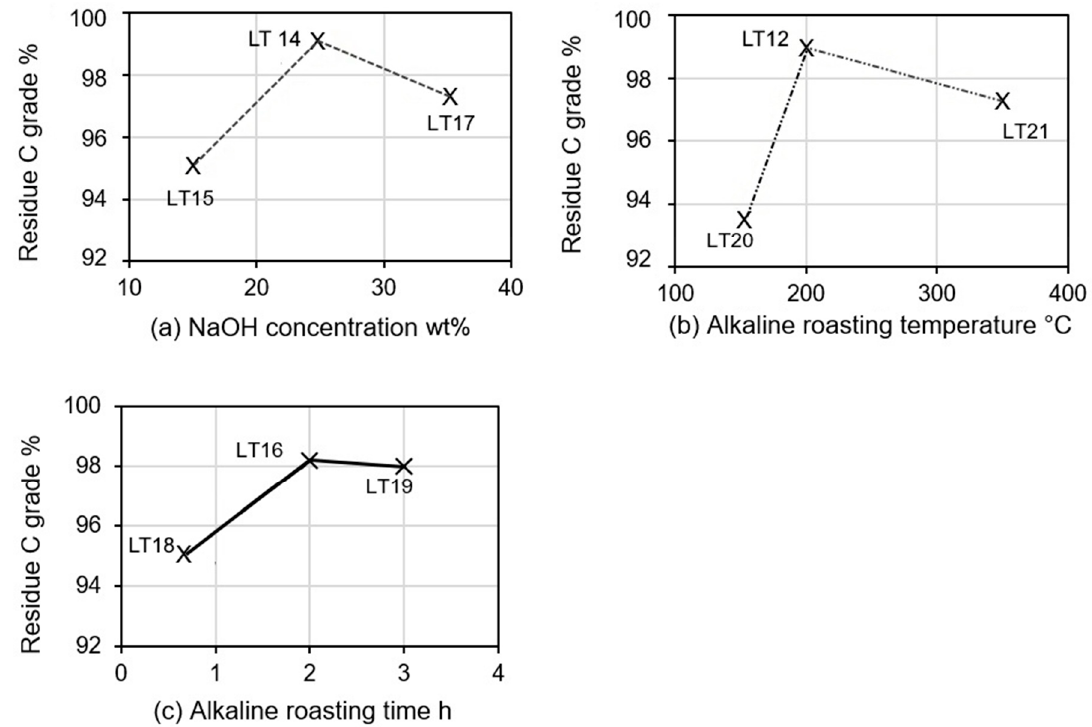
Figure 9. Effect of roasting and acid leaching process on graphite purity; ( a ) high-grade graphite at 200 °C and for 3 h leaching time; ( b ) alkaline roasting temperature at 3 h concentration time; and ( c ) roasting time at 250 °C.